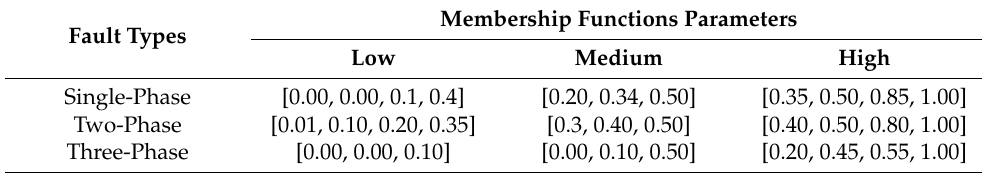
Table 6. Membership functions parameters for FIS input variables.